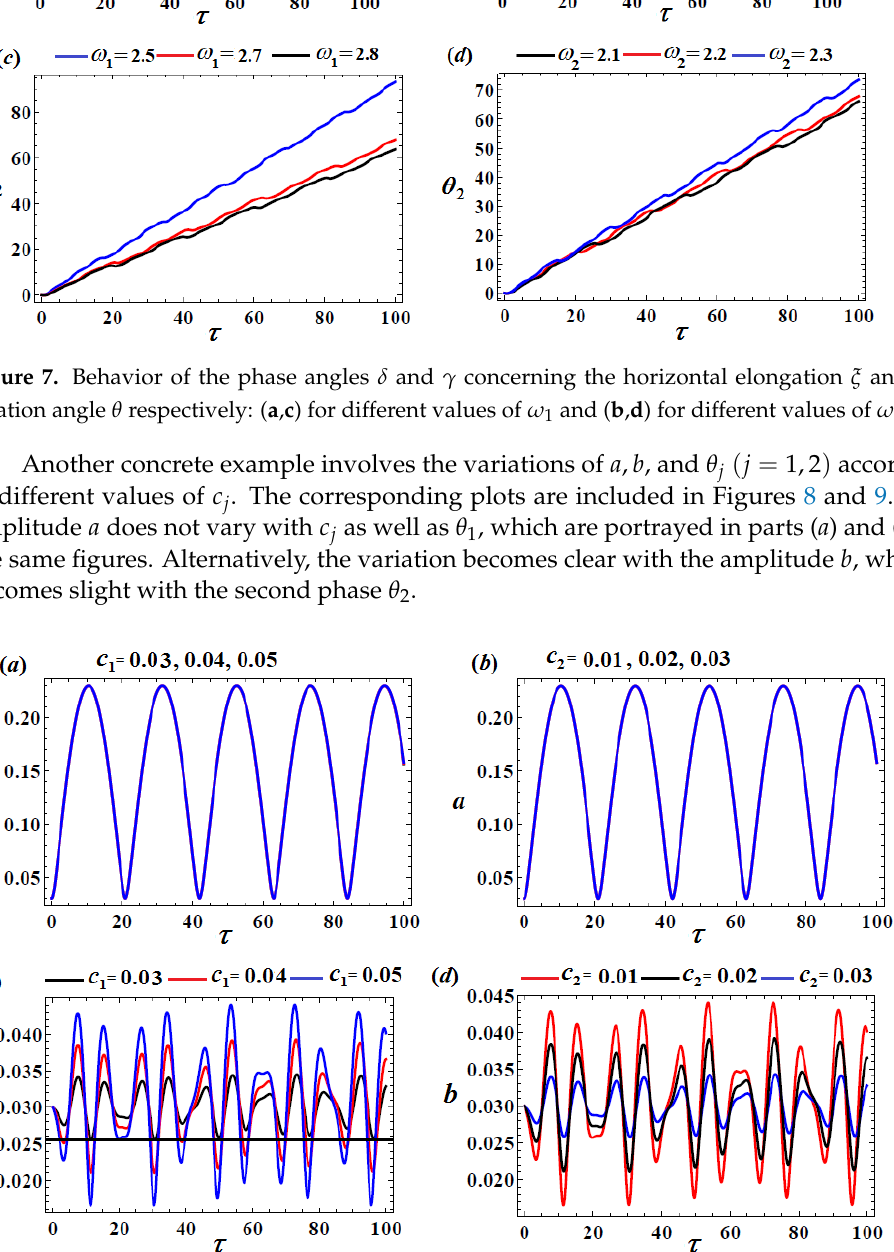
Figure 8. ( a , c ) The effect of c 1 (= 0.03,0.04,0.05 ) and ( b , d ) the effect of c 2 (= 0.01,0.02,0.03 ) m − 2 on the amplitudes a and b with regard to the horizontal elongation ξ and the rotation angle θ , respectively.